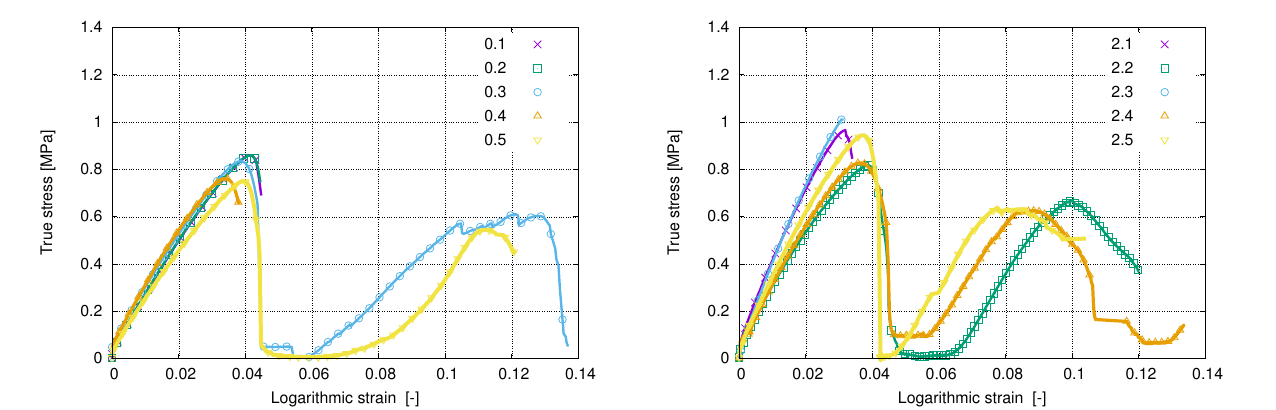
Figure 6. Stress-strain curves of specimens in group 2.